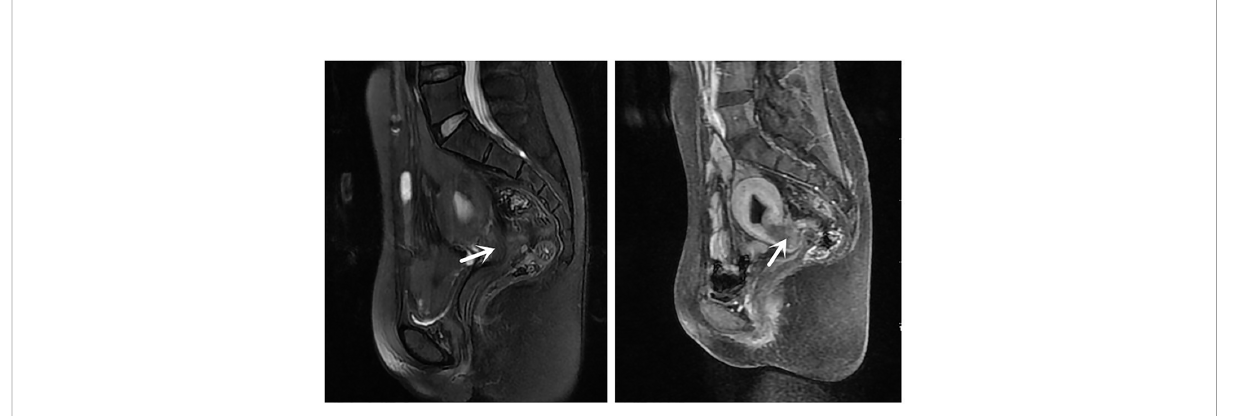
FIGURE 1 Magnetic resonance images showing an irregular mass in the cervical area. The irregular mass shadow (3.8 × 1.2 × 2.0 cm) is visible with a thickened and prominent cervical posterior wall. There is suspected penetration of vaginal posterior wall and involvement of the rectum